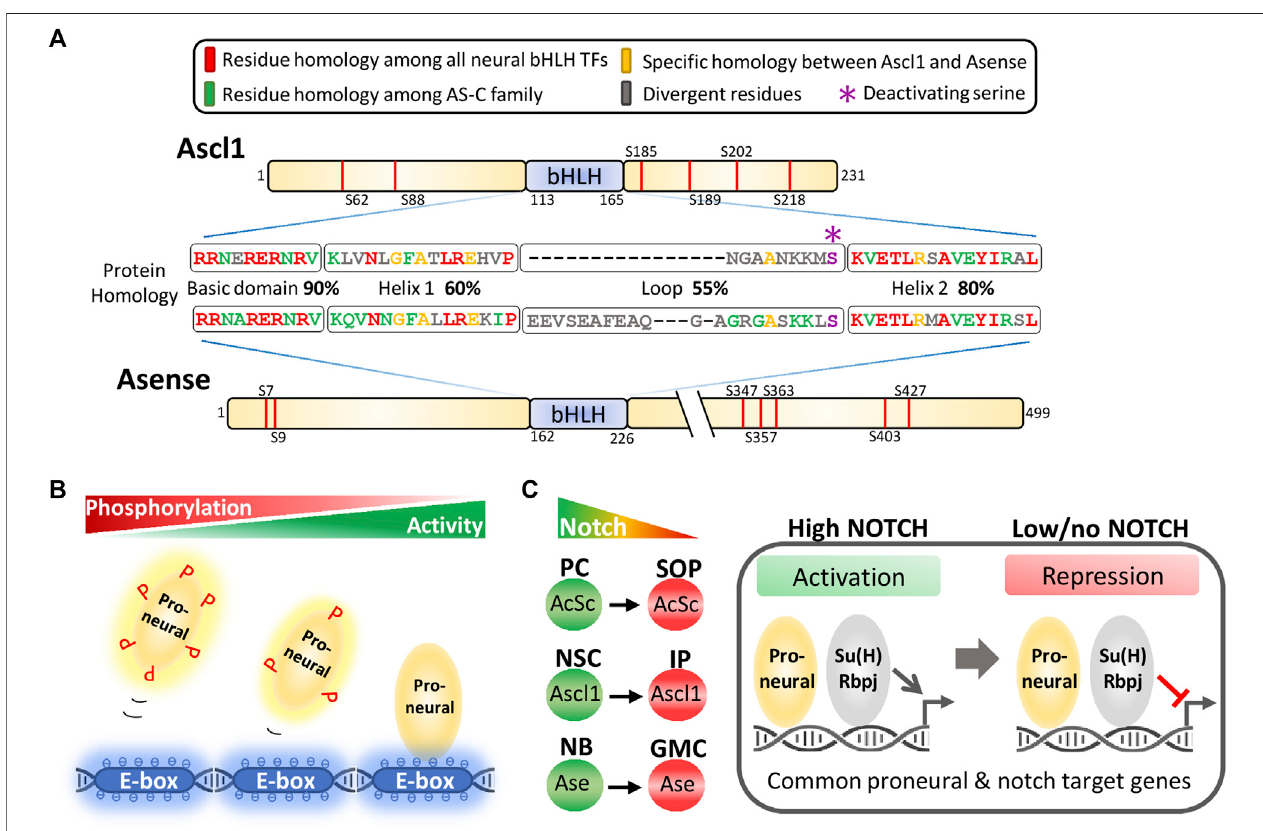
FIGURE 1 | Structural comparison and mechanisms regulating proneural transcription factor activity. (A) Structural comparison between Asense and Ascl1 proteins.Schematicofbothfactors,showingproteinsequencehomologyoftheirbHLHdomains.Phosphorylationeventsatserine/prolinesites(markedinredacrossN- and C- terminals) areshown for Ascl1(described bytherheostat model) and Asense(predicted based onsequence). (B) Rheostat regulationofproneuralfactor activity. Multi-site phosphorylation modulates the electrostatic potential of proneural proteins, impacting their ability to interact with negatively charged chromatin. (C) Cell- autonomous cross-talk between proneural and Notch pathways, as originally described in the developing peripheral nervous system of Drosophila. Left: Proneural proteins are expressed in cells with distinct Notch signalling levels (i.e., cells with distinct levels of notch receptor activation). Right: In cells with high Notch levels, the downstream effectors of Notch pathway Su(H) and Rbpj function as transcriptional activators, activating the expression of common Notch/proneural target genes in synergy with Ascl1 (right). When Notch signalling is low, Su(H)/Rbpj represses common targets in Ascl1 expressing cells. PC, proneural cluster; SOP, sensory organ precursor; NSC, neural stem cell; IP, intermediate precursor; NB, neuroblast; GMC, ganglion mother cell.